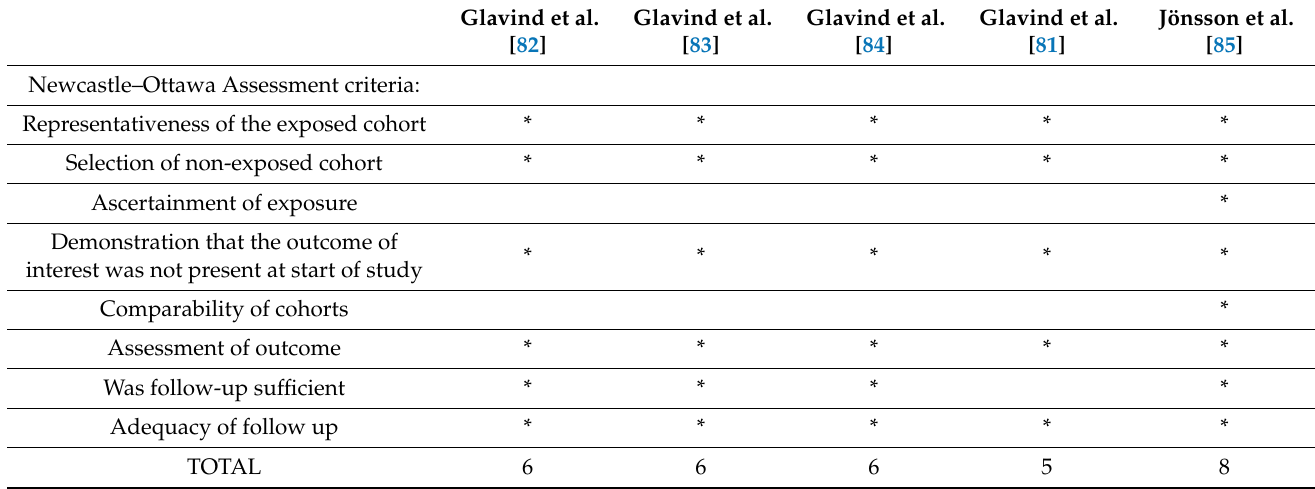
Table 6. Quality assessment of the non-randomized studies using the Newcastle–Ottawa